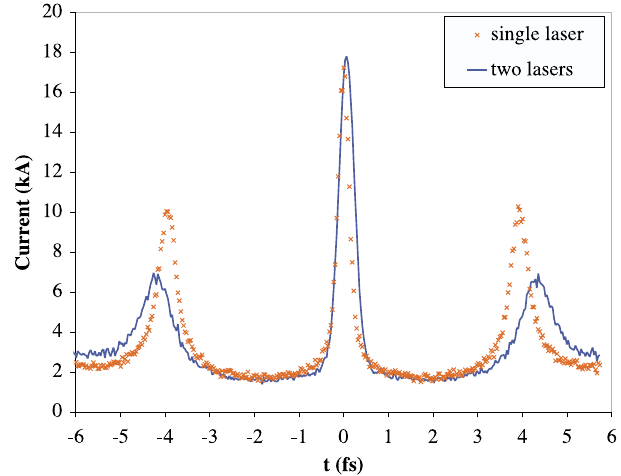
FIG. 7. (Color) Current profiles resulting from interaction with two separate lasers (line) and with a single laser ( (cid:8)